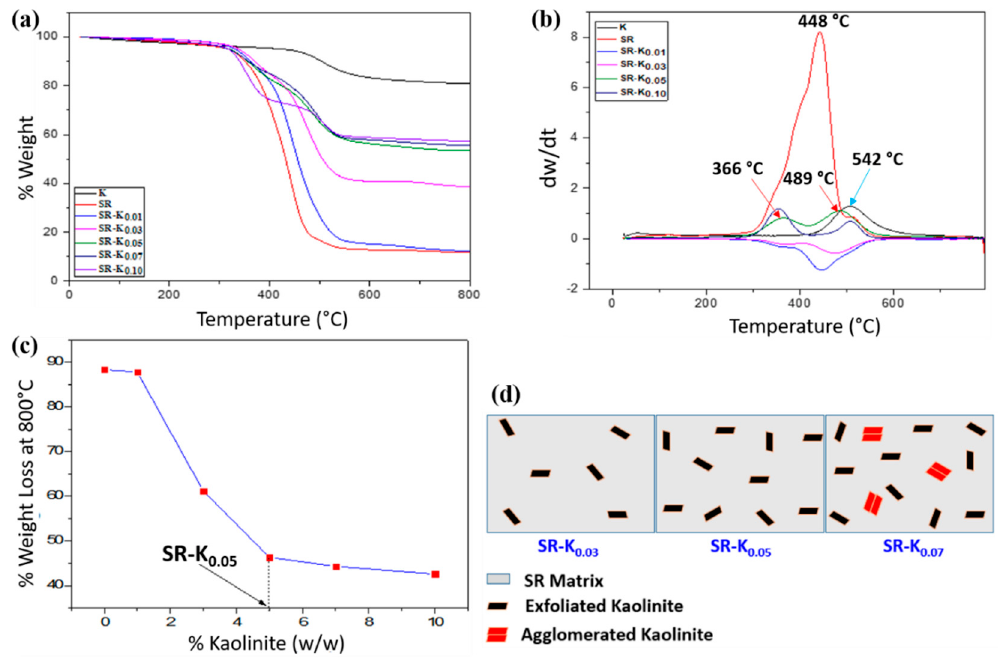
Figure 4. ( a ) Thermogravimetric analyzer (TGA) thermograms of SR and NCPs under nitrogen flow, ( b ) derivative thermogravimetric (DTG) curves illustrating specific decomposition temperatures, ( c ) effect of kaolinite loading on percent weight loss of SR and NCPs (The weight loss profile indicates that addition of small amount of K, i.e., 5 wt% dramatically improved the thermal stability.), ( d ) mechanistic view for variation in performance (SR-K 0.03 : Matrix is partially covered requiring more kaolinite, SR-K 0.05 : Matrix is completely covered with no excess kaolinite, SR-K 0.07 : Excess kaolinite leads to phase separation and agglomeration).